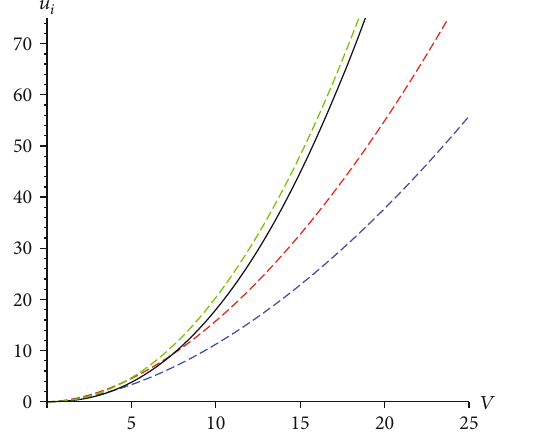
Figure 1: The relation between the strategies of governments u the strategy of terrorism v